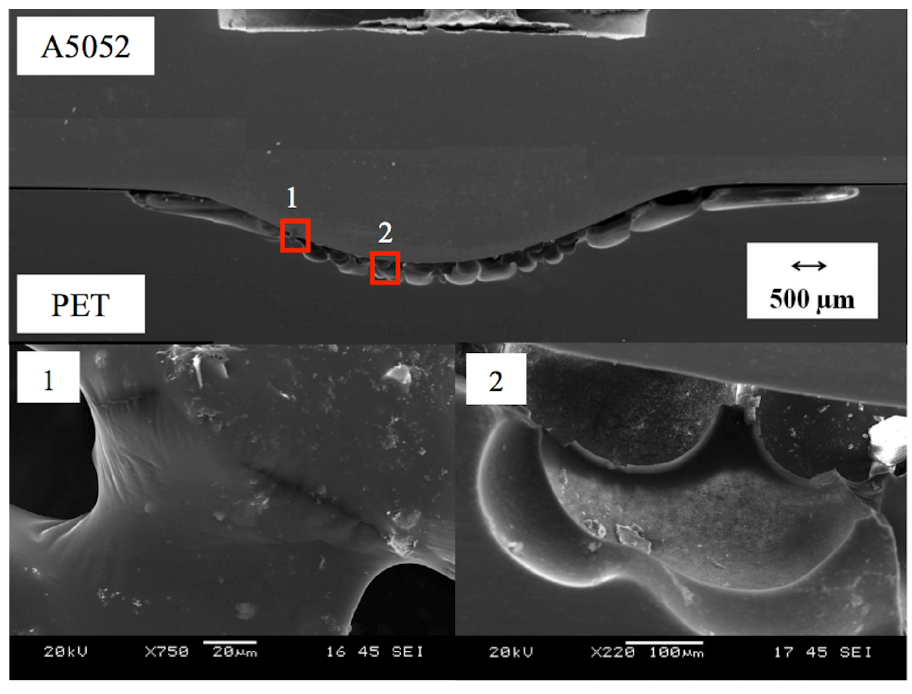
Figure 7. Cross-sectional observation of A5052(AR)-PET specimen joint at plunge speed of 20 mm/min and plunge depth of 0.7 mm.